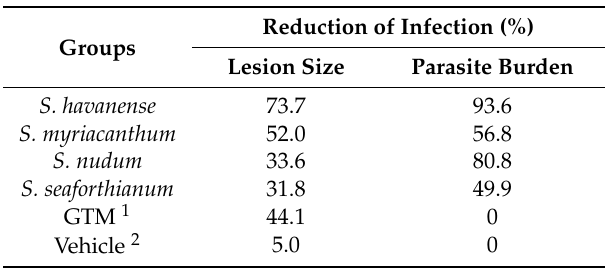
Table 3. Reduction of infection (%) of the animal groups infected with L. amazonensis and treated with Solanum extracts, a vehicle or a reference drug.